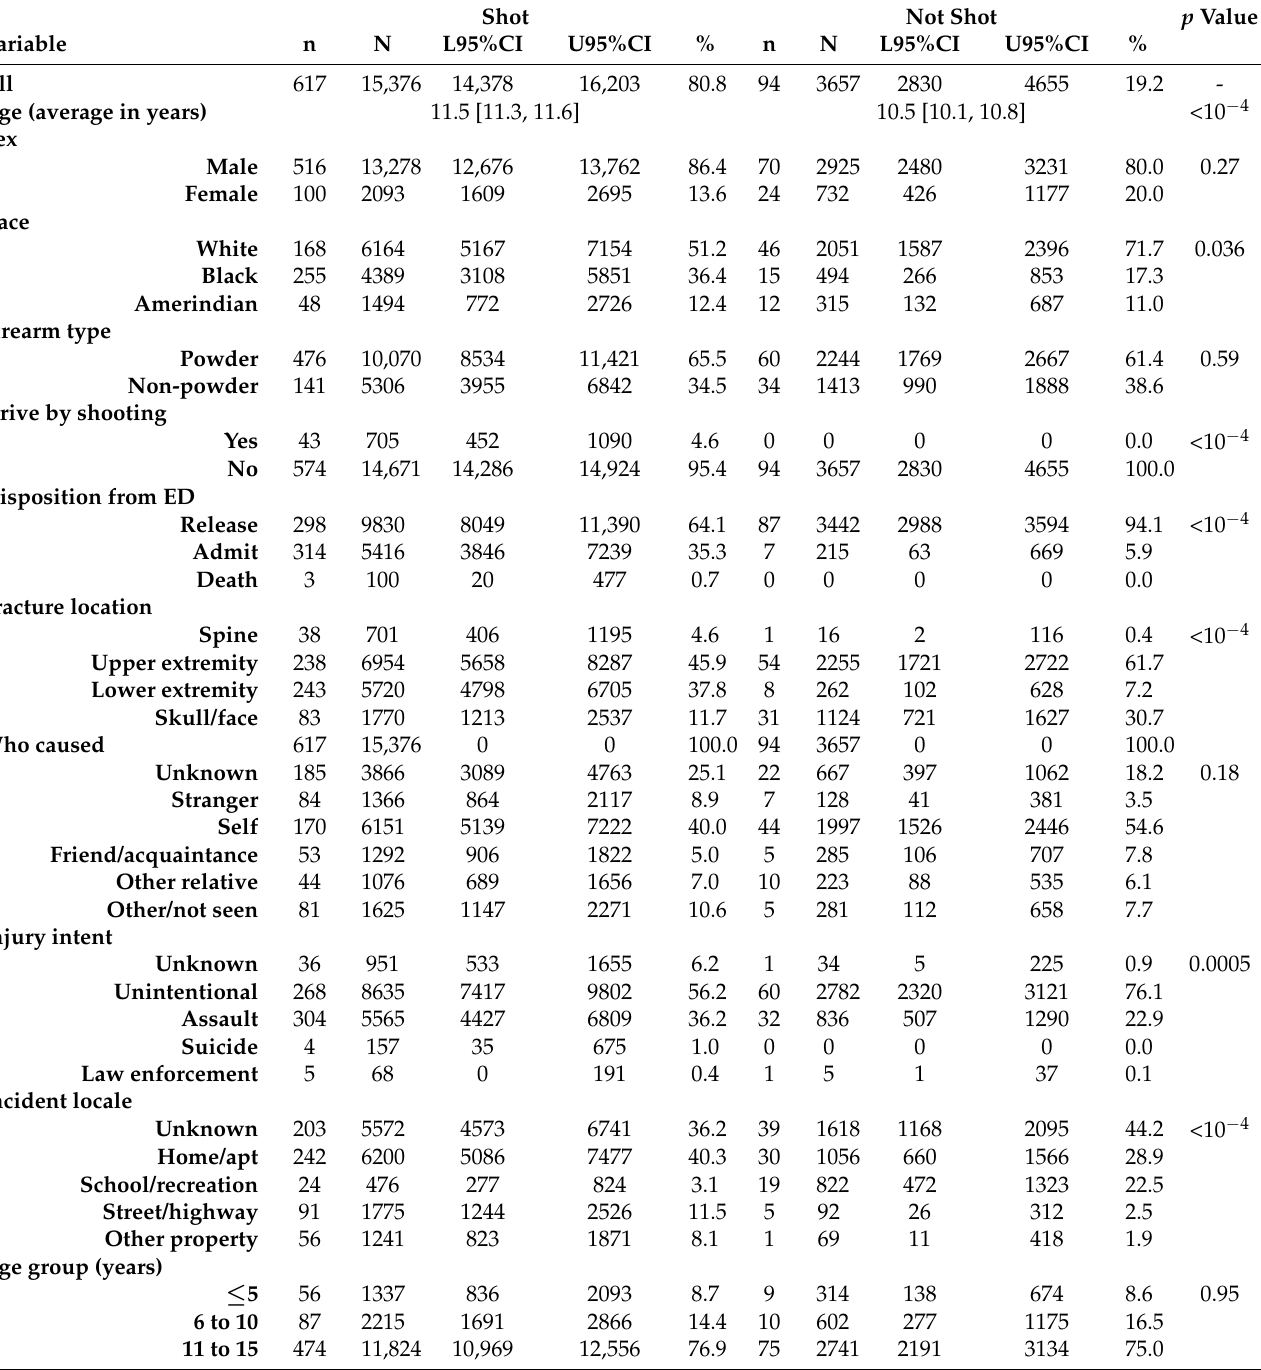
Table 5. Analyses by being shot or